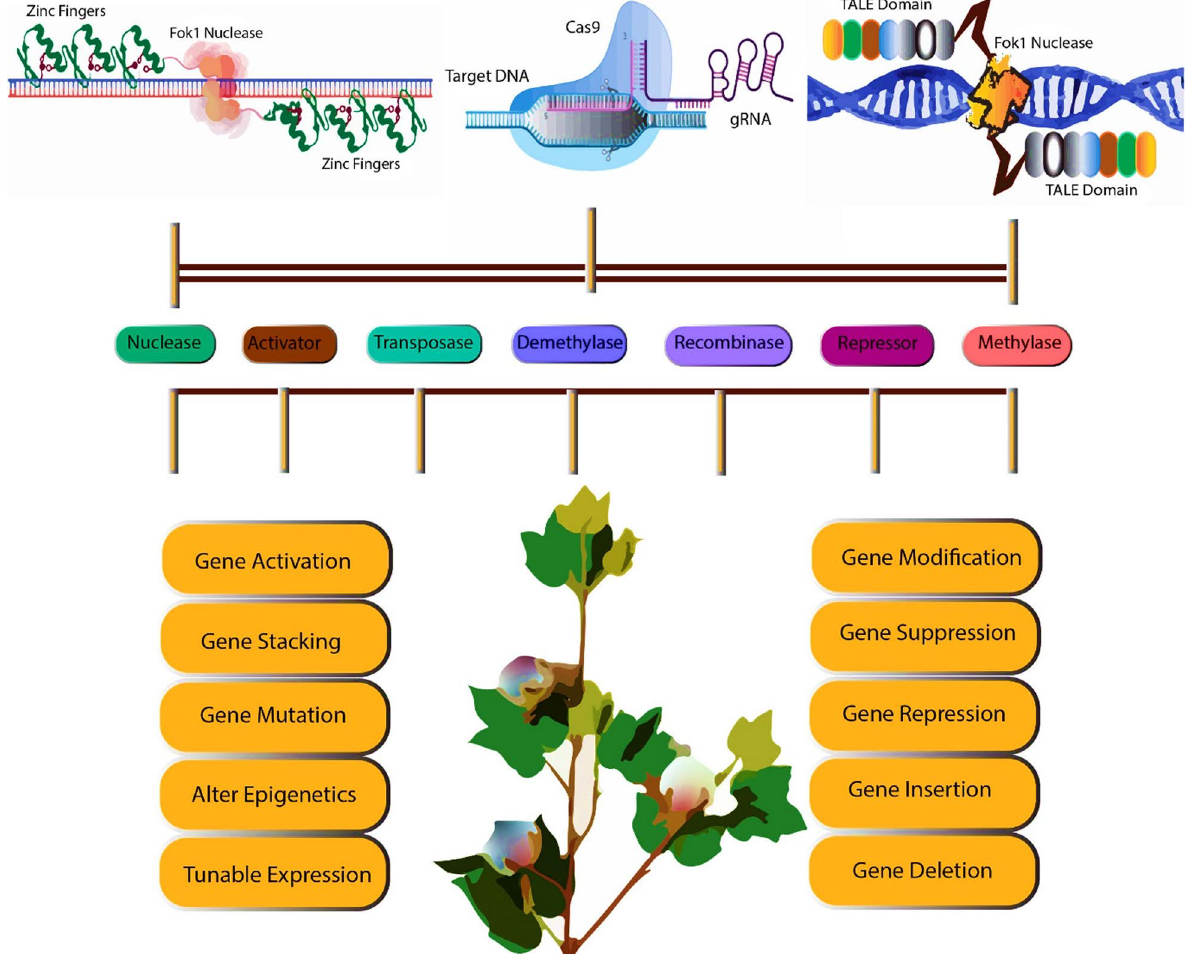
Fig. 2 Effector domain engineering with GenEd tools for different purposes. Fusion of ZFs, TALEs and CRISPR/dCas9 is possible with different effector domains for targeted gene editing and epigenetic